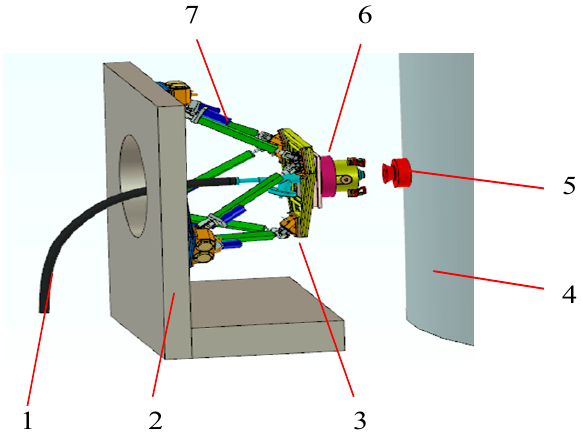
Figure 1. Automated umbilical system: 1, propellant pipeline; 2, launch tower; 3, automated umbilical system; 4, carrier rocket body; 5, propellant filling port; 6, connector and docking device; 7, hydraulic actuators.